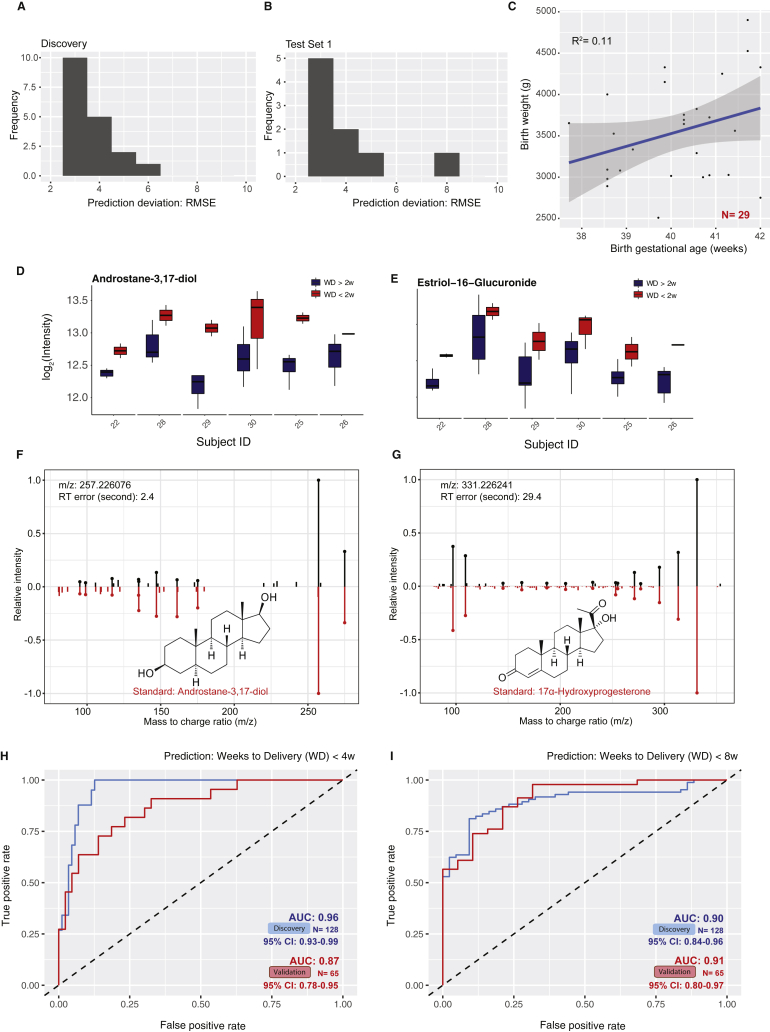
Identified Compounds Predict Gestational Age and 4 and 8 Weeks Approaching Delivery, Related to Figure 5(A and B) Histogram shows the distribution of prediction deviation (RMSE) in the cross-validation of the discovery cohort (A) and the validation cohort (B) Test Set 1.(C) The baby birth weight shows correlation with the gestational length (gestational age at childbirth). All 29 subjects who had baby birth weight information are included here. The 95% confidence interval for the linear regression is represented by the gray area.(D and E) Androstane-3,17-diol (D) and estriol-16-Glucuronide (E) show intensity range separations before or after 2 weeks approaching the delivery.(F and G) Measured MS/MS fragmentation profiles (upper) matching of androstane-3,17-diol (F) and 17α-hydroxyprogesterone (G) with the MS/MS of standard compounds (lower).(H and I) The logistic regression models can accurately identify the third trimester plasma samples approaching delivery (weeks to delivery, WD < 4w (H), WD < 8w (I); only includes women with natural labor onset). Note that the discovery results were from the 10-fold cross-validation (CV) instead of direct fitting to avoid over-fitting.